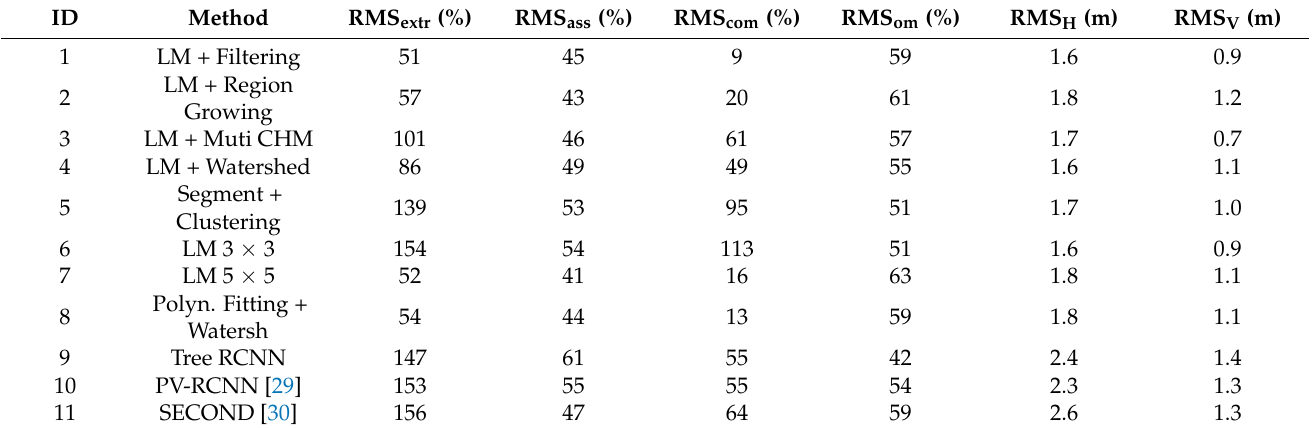
Table 6. Detection performance of different models for all